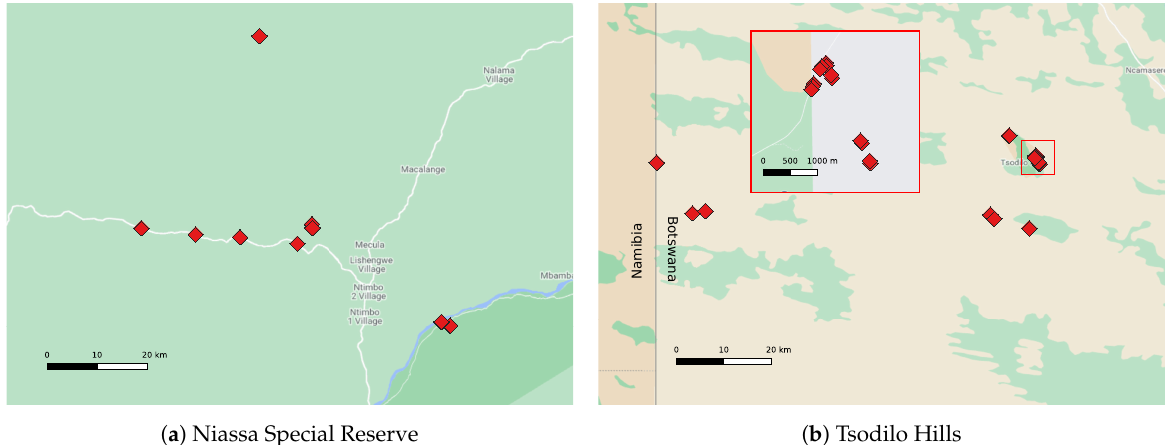
Figure 4. Plot distribution across study areas in ( a ) Niassa Special Reserve and ( b ) Tsodilo Hills. In all cases except the magnified region in ( b ), the red diamonds represent two or three plots placed in parallel. Within the magnified region, diamonds show single